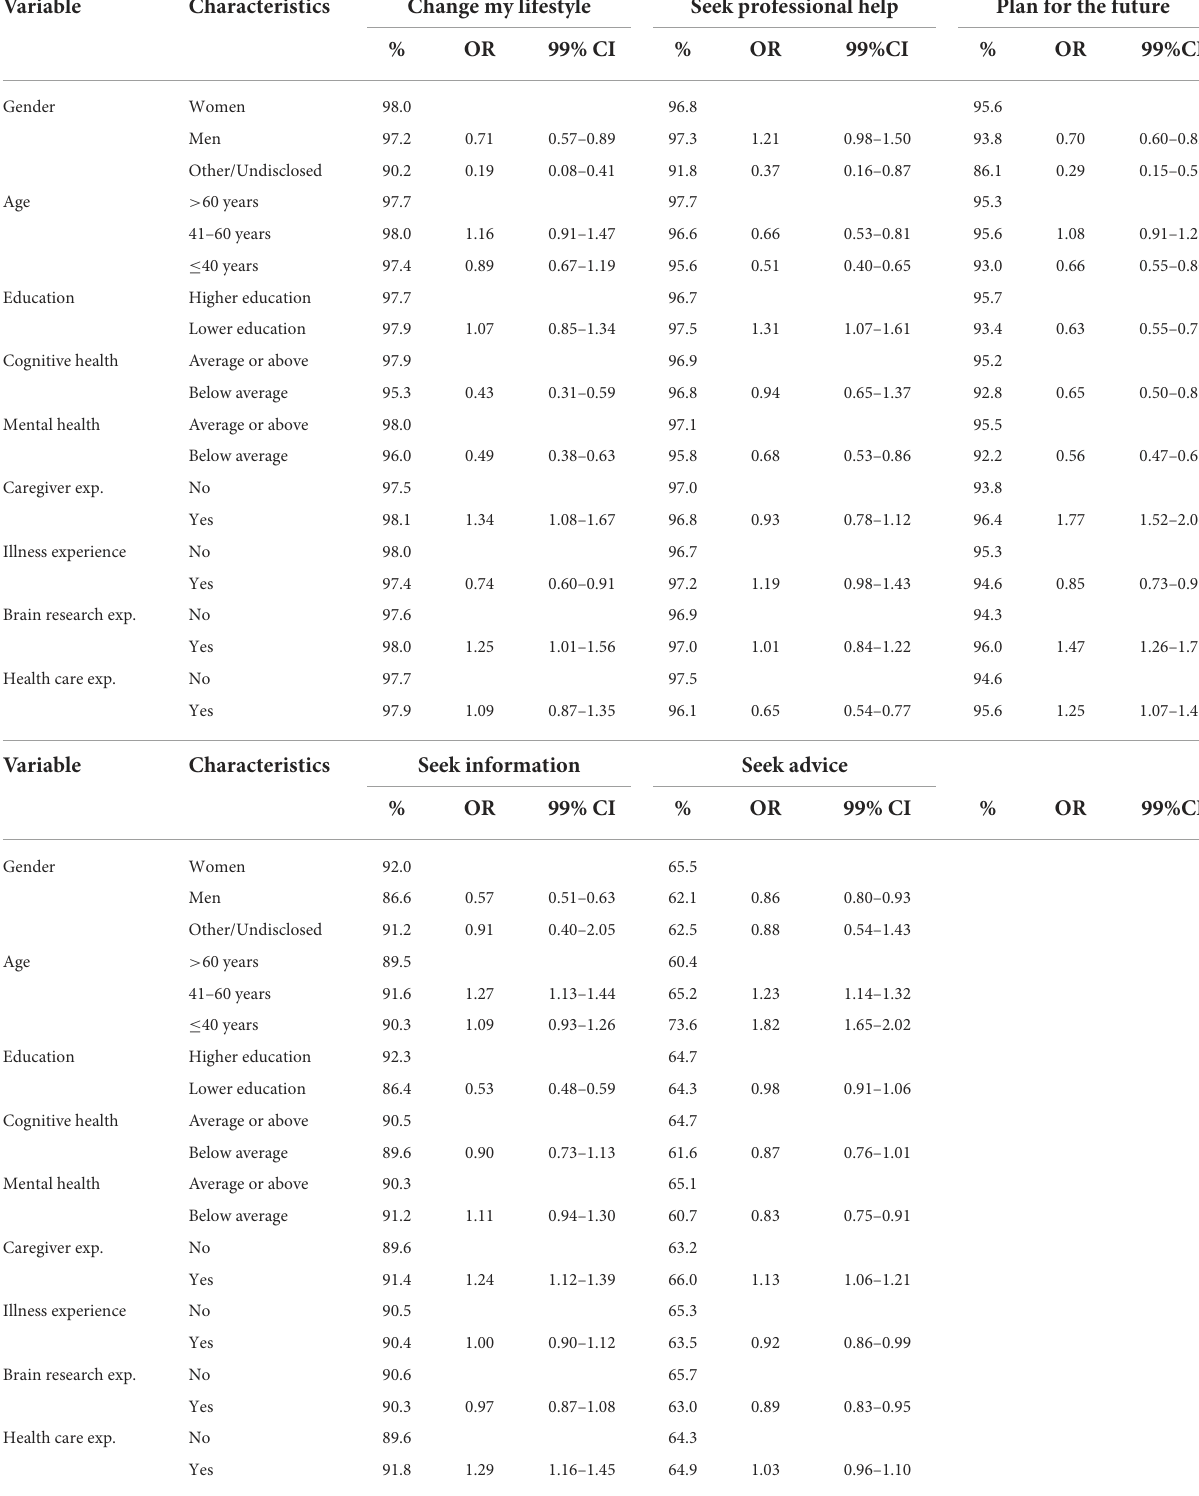
TABLE 4 Likely reactions to test results if found to be at risk of brain disease.